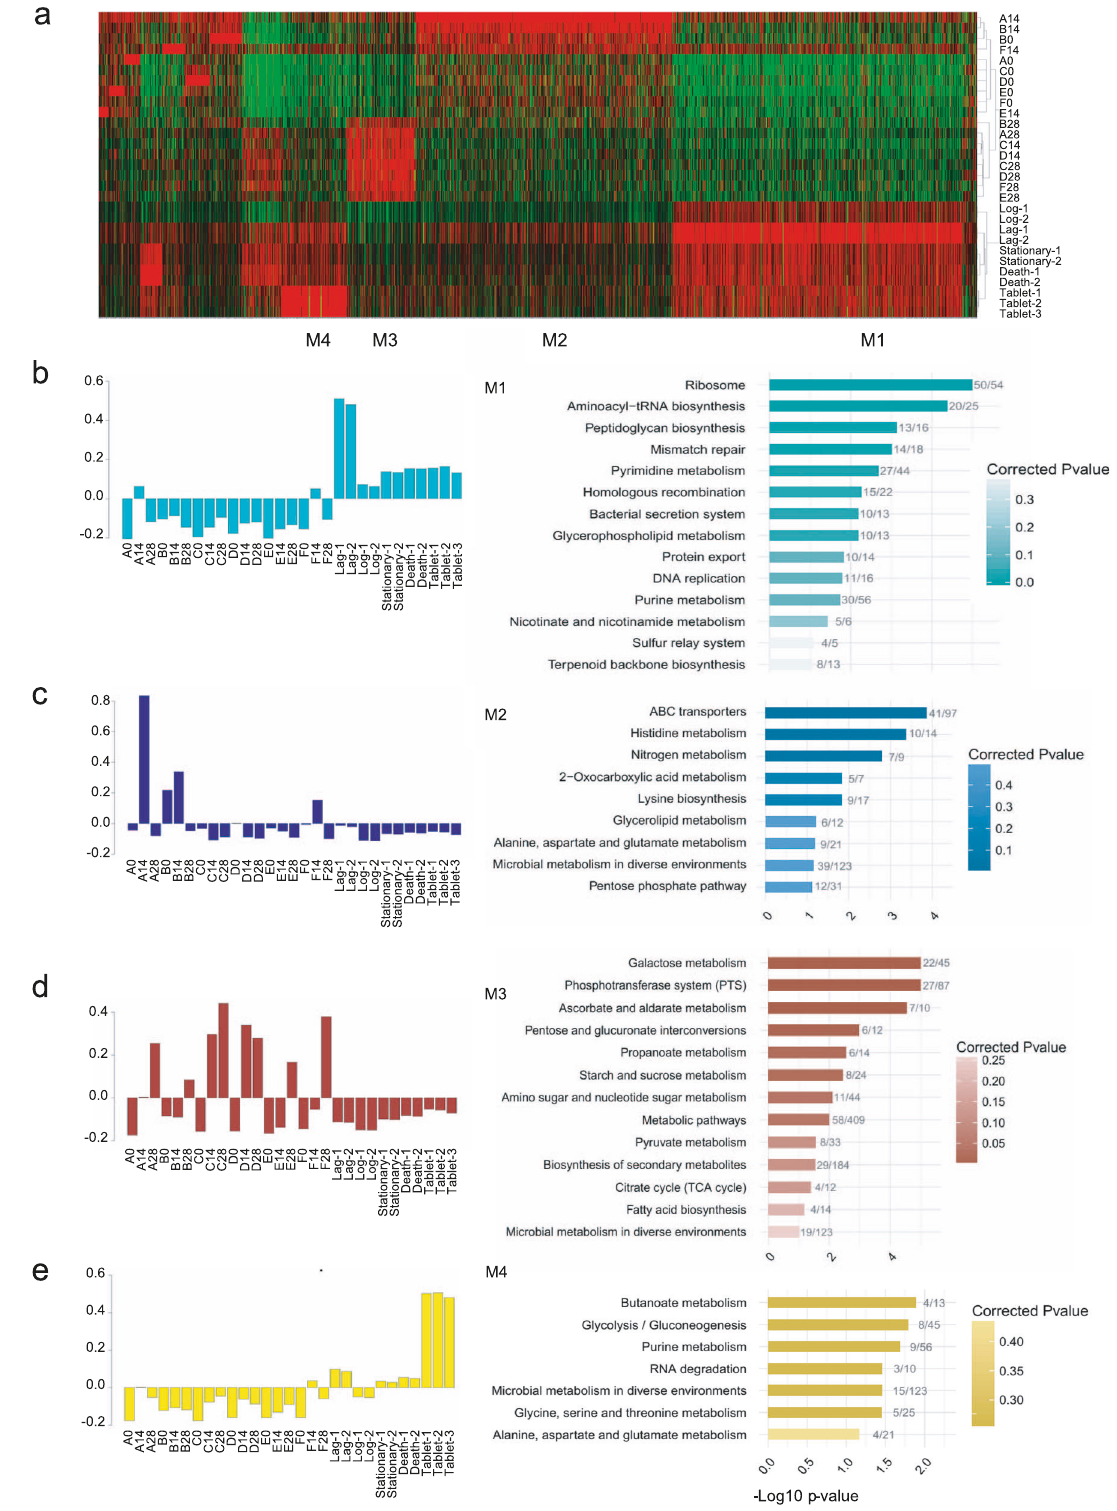
Fig. 2 Transcriptional dynamics of the ingested L. casei Zhang in the human gut. a Heatmap representation of differentially expressed genes mapped onto the L. casei Zhang genome, ranked by the co-expression modules. b – e Bar plots of eigengene value and KEGG pathway enrichment of corresponding genes in module 1 ( b ), module 2 ( c ), module 3 ( d ), and module 4 ( e